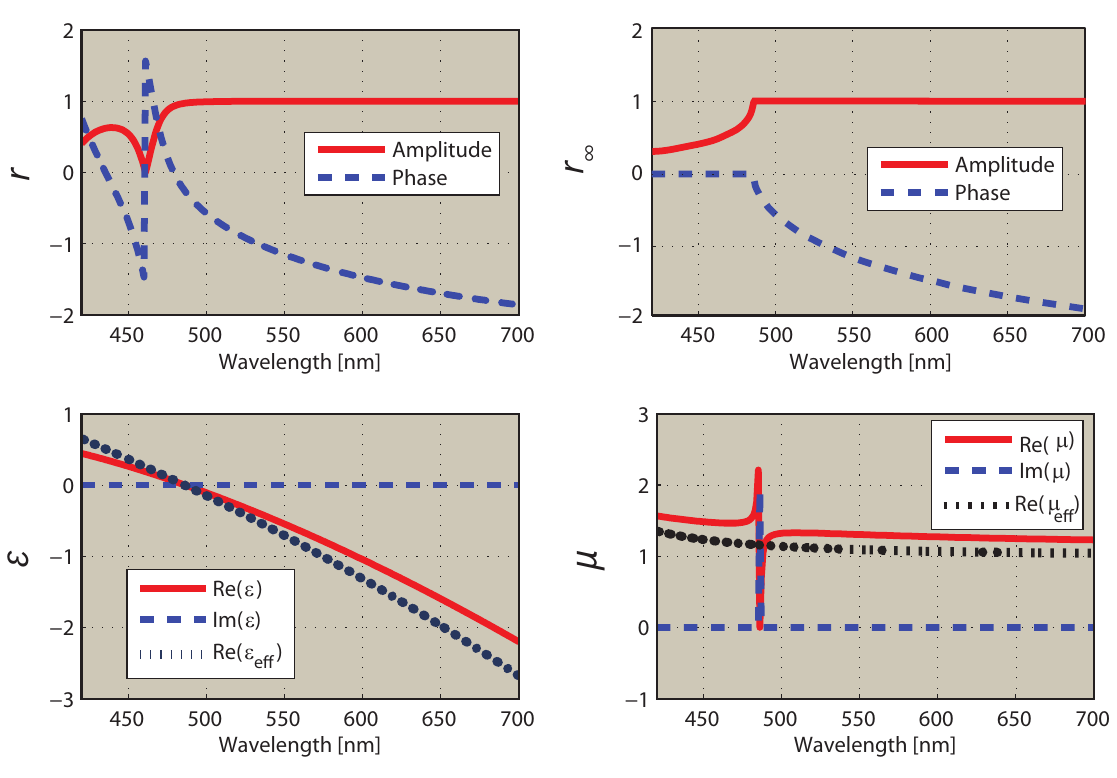
Figure 3. Retrieved permittivity and permeability when the shift operator with a shift value of 15 nm applied in order to move the point of total reflection to the edge of the forbidden zone. The rest is as in Figure